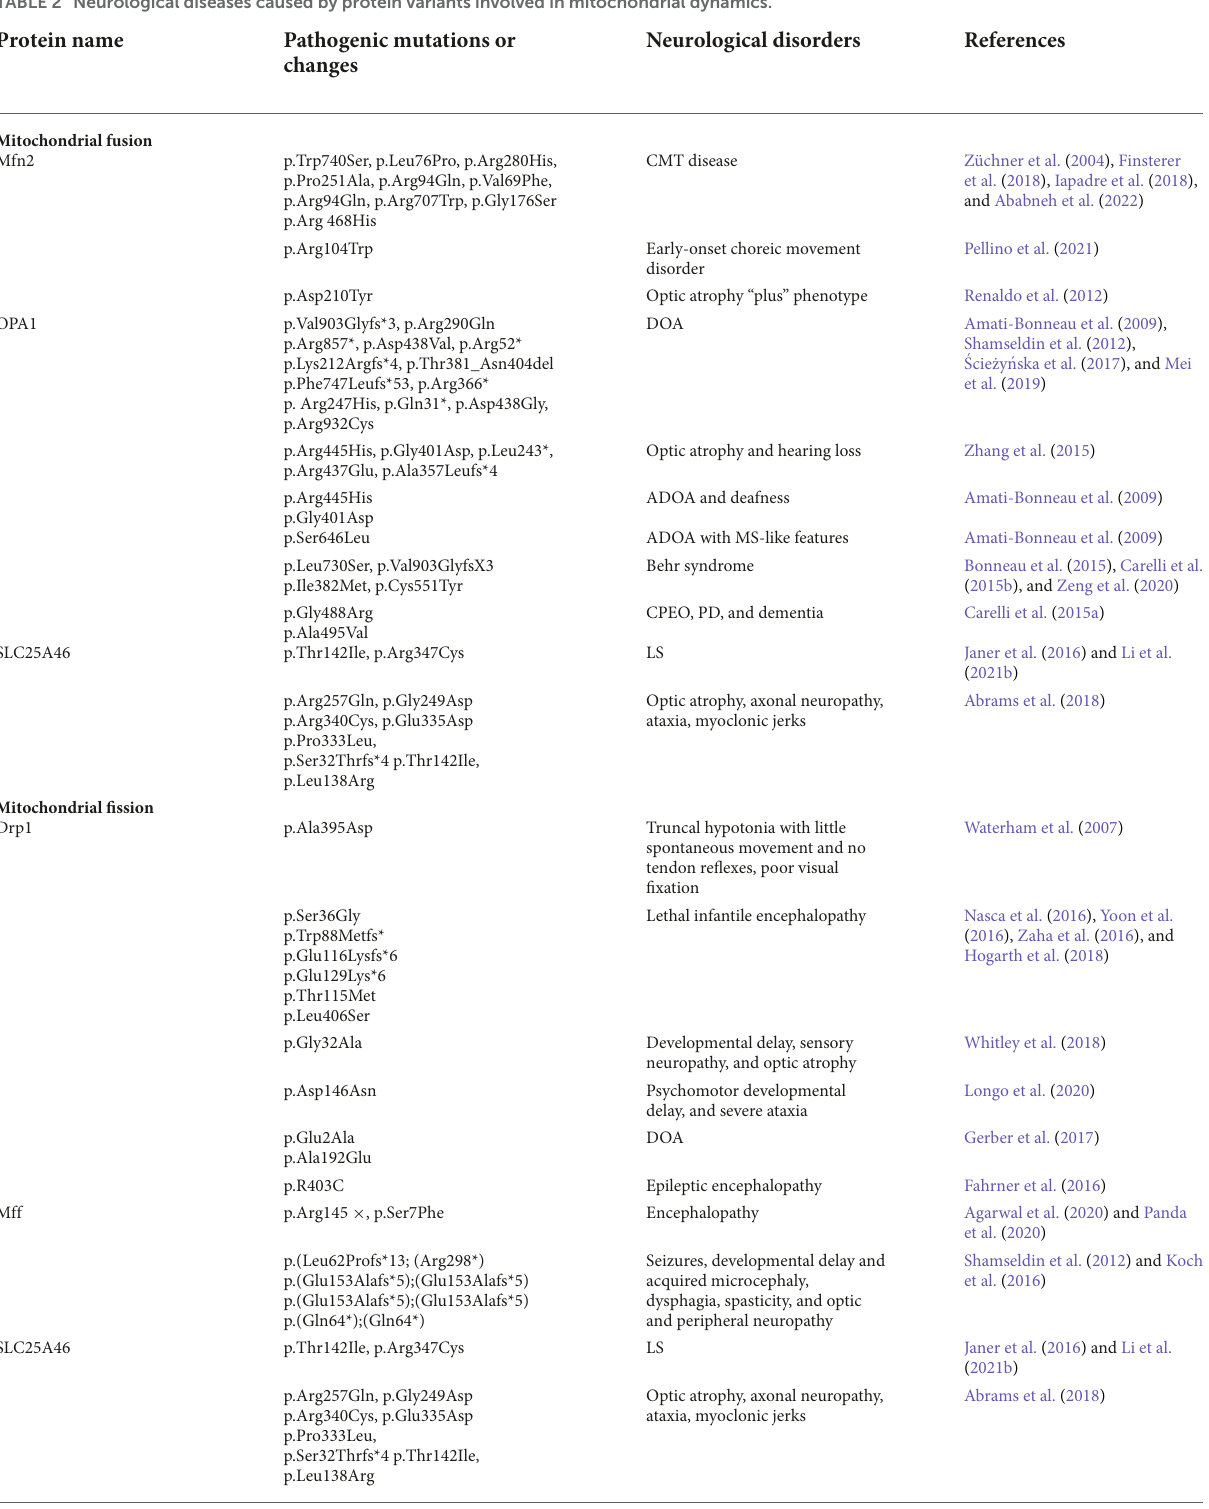
TABLE 2 Neurological diseases caused by protein variants involved in mitochondrial